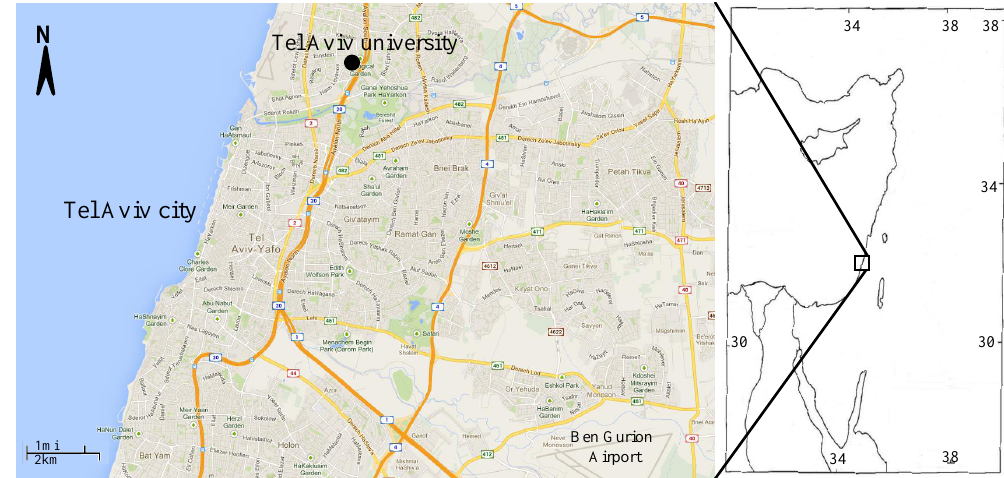
Figure 1. Location of the sampling station at Tel Aviv University marked in black (Google Maps, with modification,